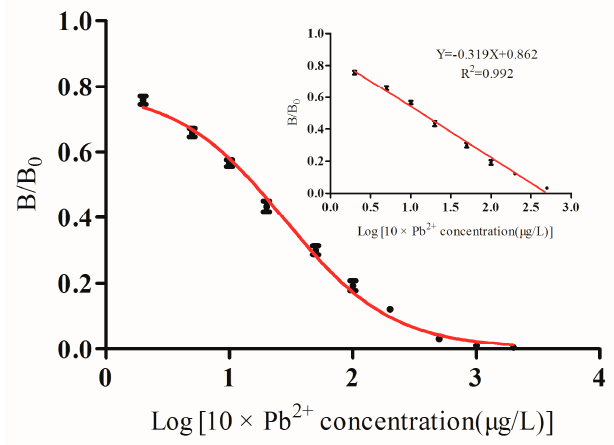
Figure 3. Standard curve of the competitive CLEIA for lead ions.